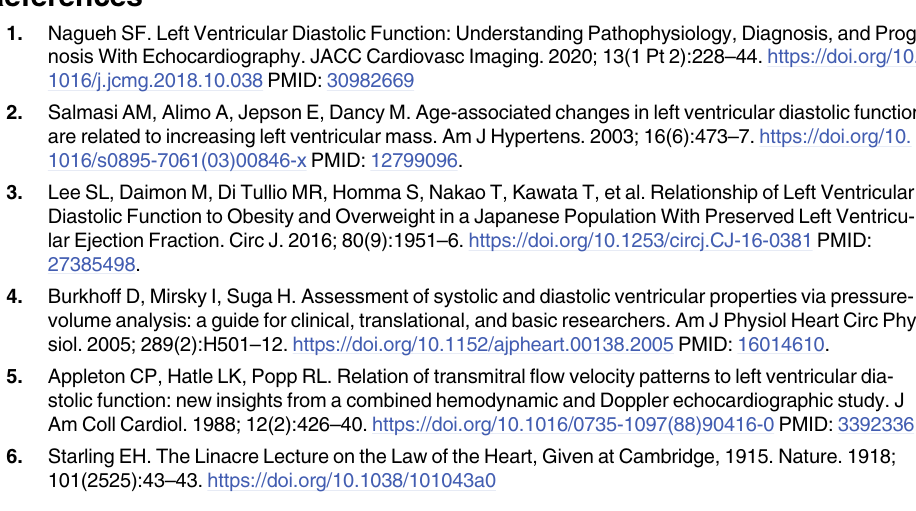
S5 File. Minimal data sets for sarcomere lengths. This file contains values for sarcomere length of atrium and ventricle in masu and cherry salmon, respectively. S1 Raw images. Raw data images for Fig 5A and S9